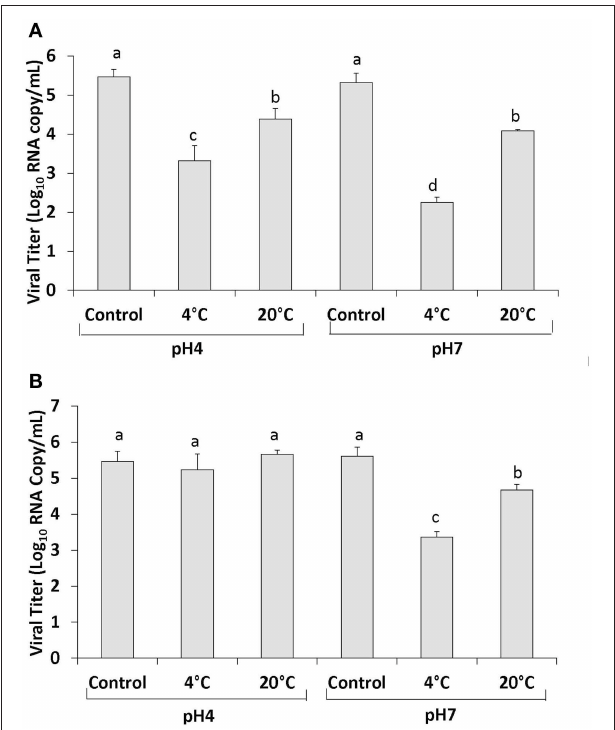
FIGURE 1 | Human NoV GII.4 inactivation by HPP in PBS (A) and strawberry puree (B). Each bar represents average of three replicates ± 1 standard deviation. Groupings (a, b, c, d) are based on one-way ANOVA analysis using Tukey’s comparisons, with a 95% C.I. Values with different lowercase letters (a, b, c, d) are significantly different ( p < 0.05) and values sharing the same lowercase letters (a, b, c, d) are not significantly different ( p > 0.05).